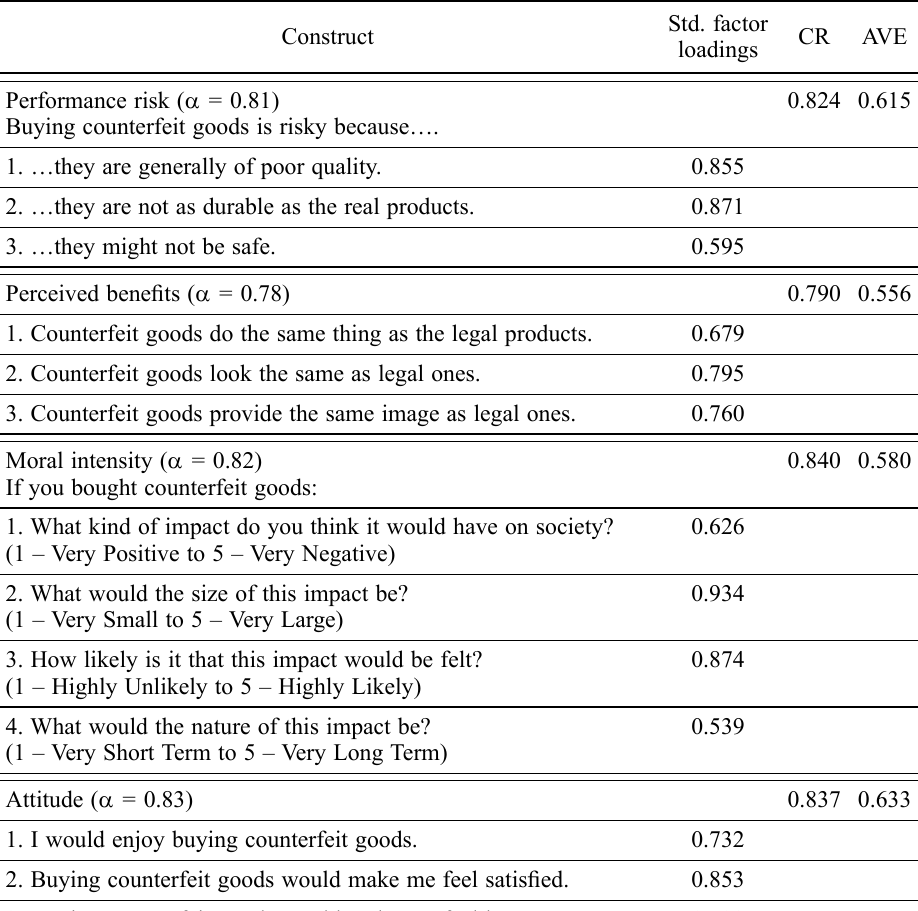
Table 1. Measurement model